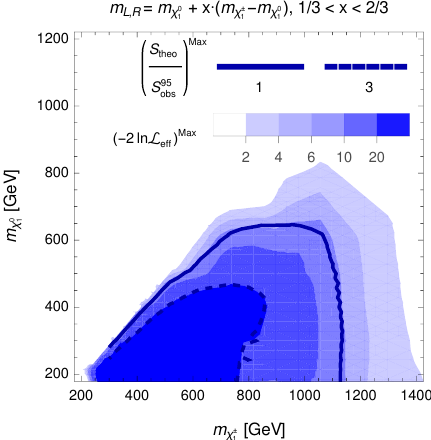
Figure 20. Recasting of the exclusion limits corresponding to ref. [487], figure 8c. The generated MSSM parameter points have the mass hierarchy M , i.e. Bino-like LSP, 1 < m L , R < M 2 < µ intermediate sleptons of the 1st and 2nd generation, and a Wino-like pair of χ 0 . The slepton /χ ± 2 1 masses satisfy x = ( m ) / ( m ) with 1 / 3 < x < 2 / 3 . The thick solid blue contour − m L , R − m χ 0 χ 0 1 χ ± 1 1 can be directly compared to the 95% C.L. exclusion contour of ref. [487], figure 8c; the thick dashed blue contour corresponds to points where the predicted signal yield is three times higher than the respective ATLAS upper limit in at least one signal region. The blue coloured regions correspond to various values of the maximum effective ( − 2 ln L ) of any analysis implemented in eff GAMBIT / ColliderBit . The plots in section 6.4 show only the region corresponding to ( − 2 ln L eff ) = (cid:1) 6 , which is very close to the line where (cid:0) S 95% ≥ 1 for at least one signal region; see text for theo /S obs more details.